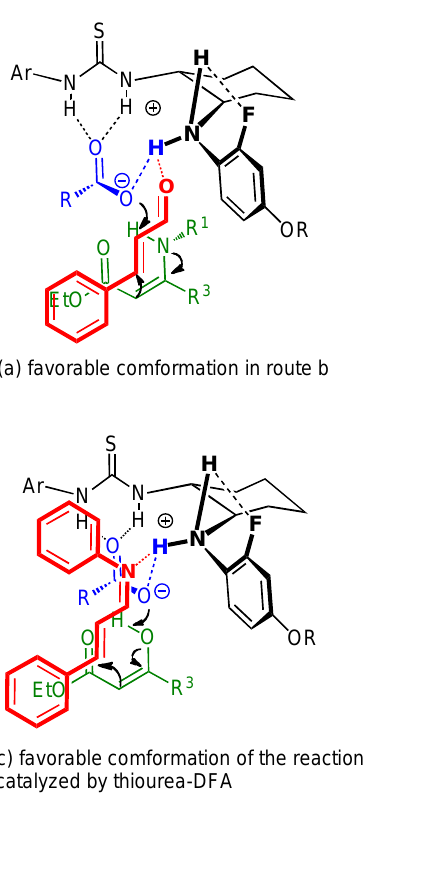
Figure 3. Proposed TS models for the co-catalyzed three-component